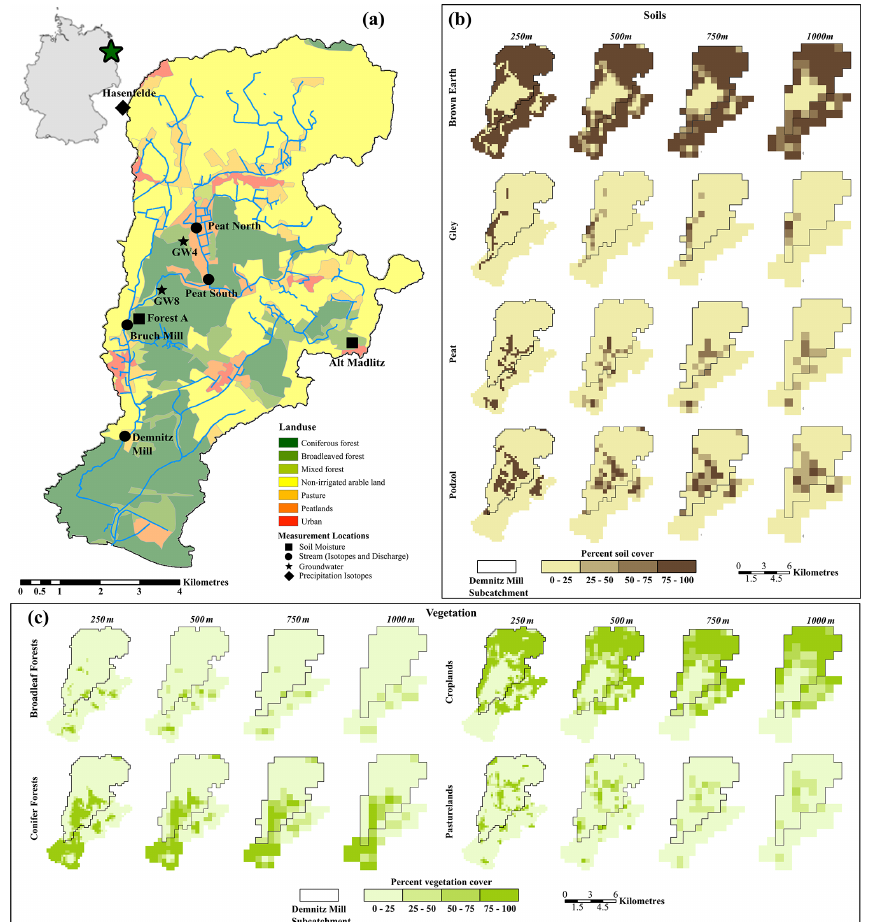
Figure 1. (a) The location of the Demnitzer Millcreek catchment (DMC) in Germany and field measurement locations within the DMC for soil moisture (squares), stream (circles), groundwater (stars), and precipitation isotopes (diamonds). (b) Soil coverage of brown earth, gley, peat, and podzol for spatial resolutions 250, 500, 750, and 1000m. (c) Vegetation coverage of broadleaf forests, conifer forests, croplands, and pasture lands for each spatial resolution. Black boundaries show the calibration extent of the Demnitz Mill subcatchment.